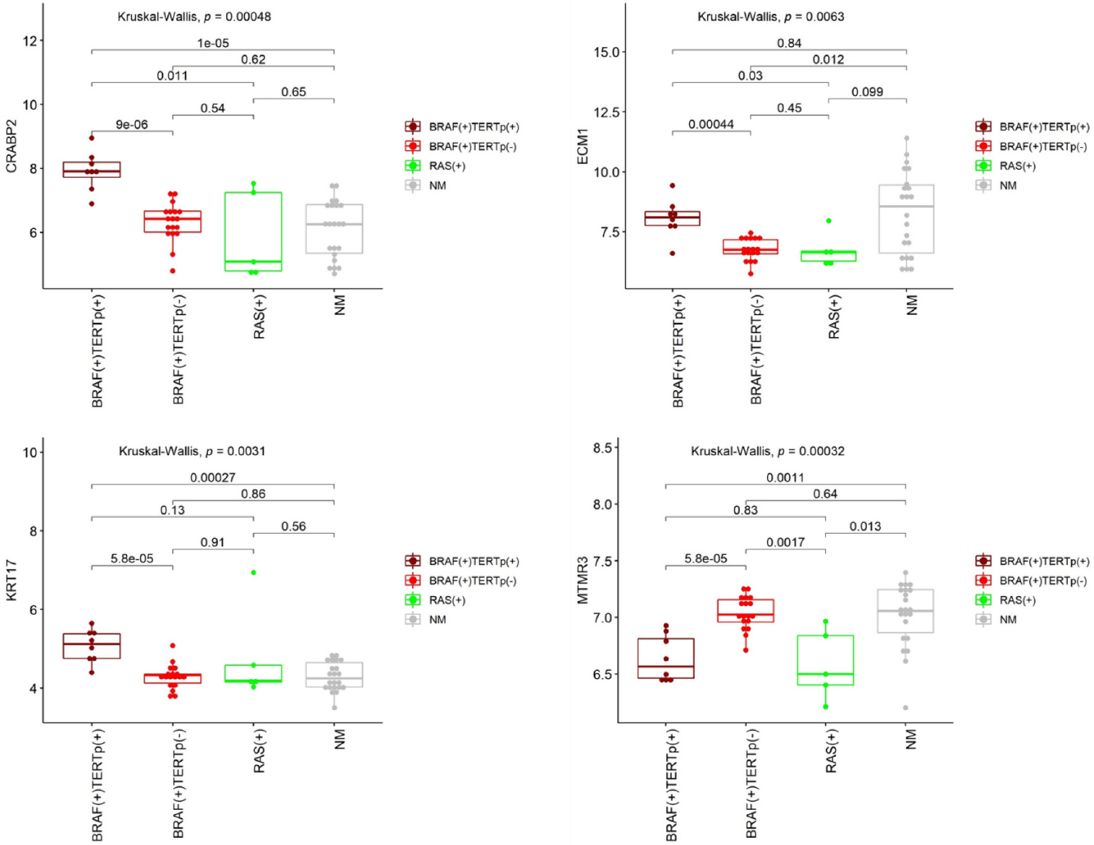
Figure 4. Expression of four genes significantly differentiating BRAF( + )TERTp( + ) and BRAF( + )TERTp( − ) PTCs in all analyzed PTC cases; RAS( + ) cohort was BRAF( − ) and TERTp( − ). p -values shown on plots were calculated with Kruskal-Wallis and two-tailed Mann-Whitney tests.